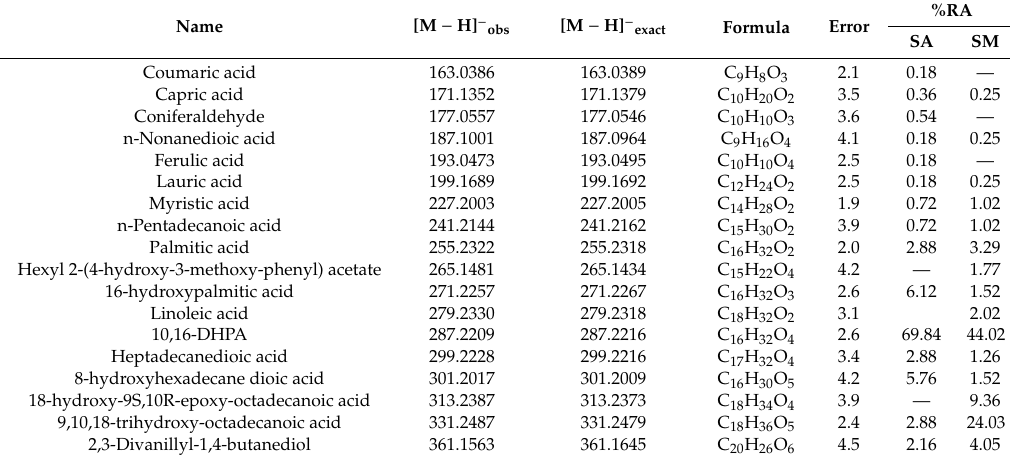
Table 1. Identification of the Main Compounds in the Soluble Fraction of the Alkaline